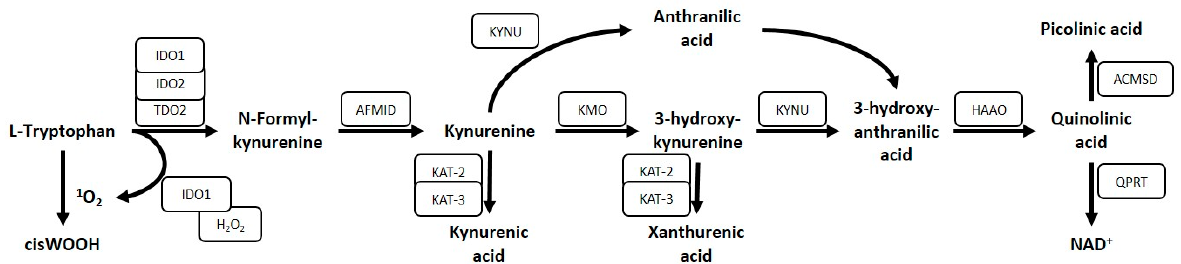
Figure 2. The kynurenine pathway. IDO, indoleamine 2,3-dioxygenase; TDO, tryptophan 2,3-dioxygense; AFMID, aryl- formamidase; KAT-2, aminoadipate aminotransferase; KAT-3, kynurenine aminotransferase 3; KYNU, kynureninase; KMO, kynurenine 3-monooxygenase; HAAO, 3-hydroxyanthranilate 3,4-dioxygenase; ACMSD, aminocarboxymuconate semialdehyde decarboxylase; QPRT, quinolinate phosphoribosyltransferase.